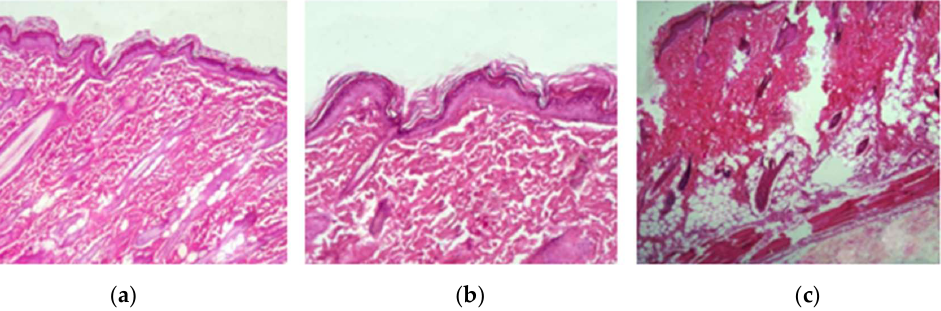
Figure 7. Histopathological analysis of: ( a ) positive control; ( b ) FLU–ACT–coloaded NLC treatment; ( c ) negative control.